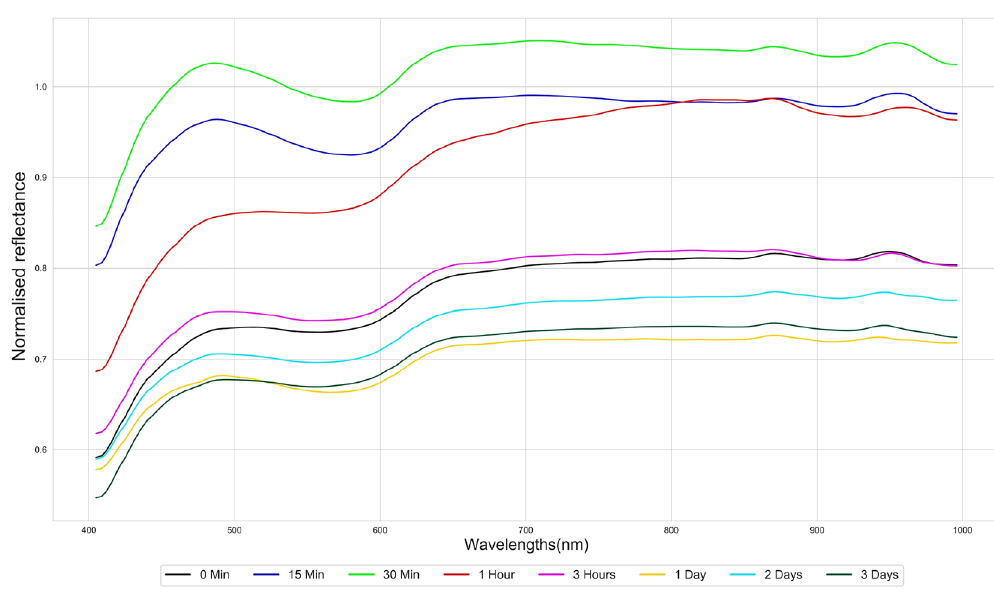
Figure 10. Mean spectral variation of the paper towel (paper1) over